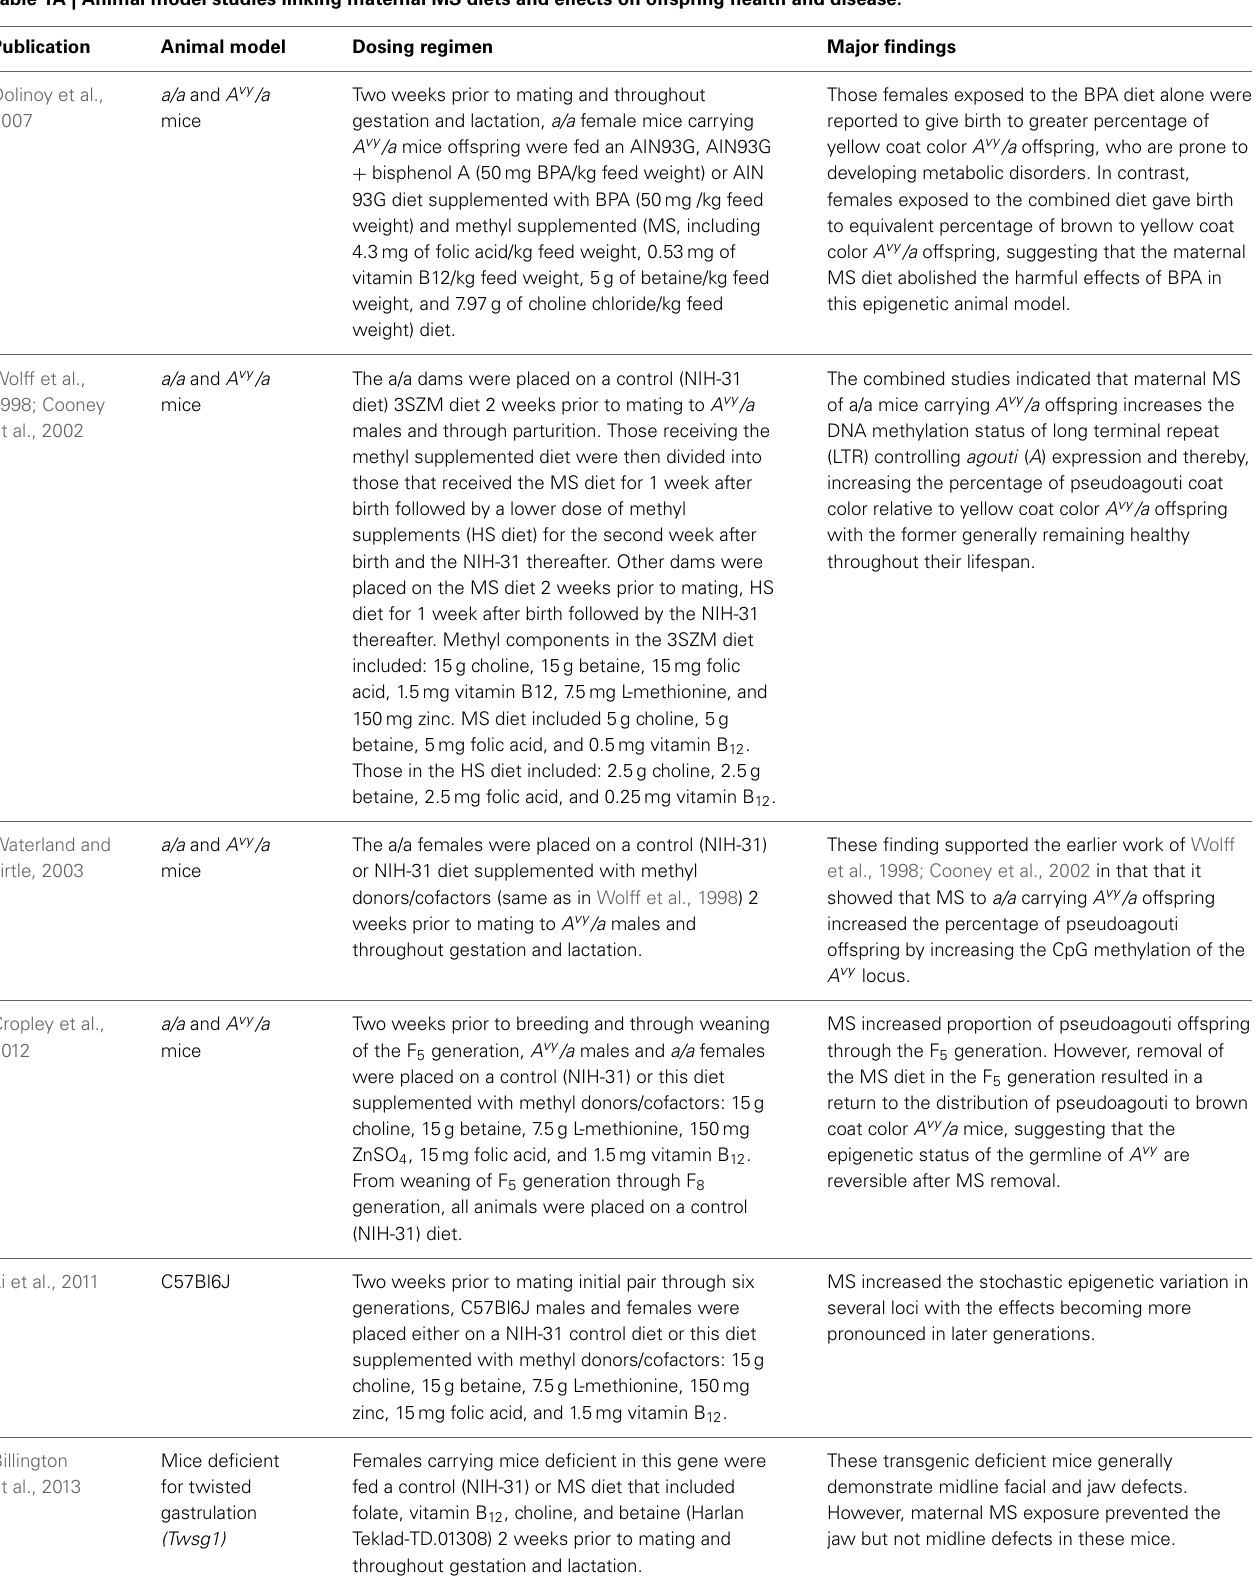
Table 1A | Animal model studies linking maternal MS diets and effects on offspring health and